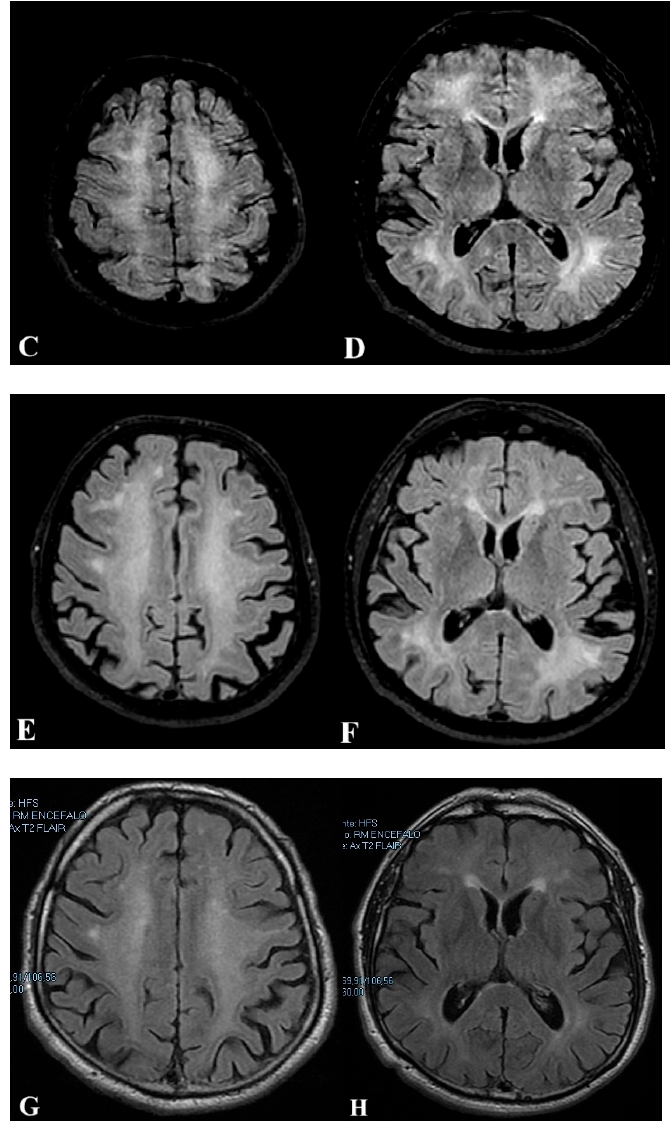
Figure 2. Brain Magnetic Resonance (MRI) 25 days after the carbon monoxide intoxication ( A , B ) showing diffused leukoencephalopathy; MRI after 8 hyperbaric oxygen (HBO) treatments with worsening findings ( C , D ); MRI after 36 days of HBO treatments showing persisting pathological findings ( E , F ); MRI performed 317 days after CO intoxication with general improvement ( G , H ). Sequences are fluid ‐ attenuated inversion recovery (FLAIR).